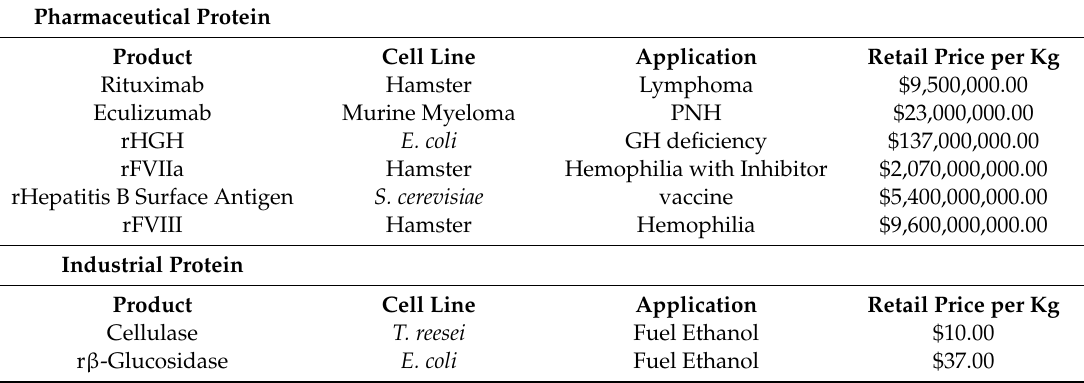
Table 1. Retail pricing of recombinant proteins. Abbreviations: r—recombinant; PNH—paroxysmal nocturnal hemoglobinuria; HGH—human growth hormone; rFVIIa—recombinant activated factor VII; rFVIII—recombinant factor VIII.